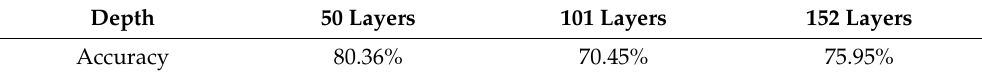
Table 8. The comparison of culm classification performance by deep residual network depth.